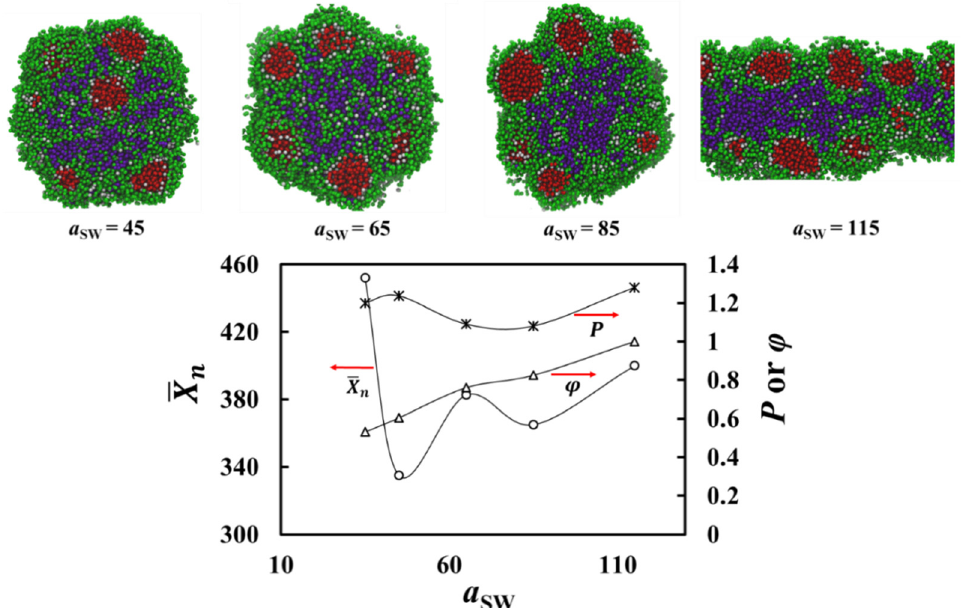
Figure 6. Aggregate snapshots and analysis of the aggregate structural changes when a SW is varied. At the top, the cross-sections of the final morphology of the system containing A 19 (4%), A 1 - b -S 6 (13%), and S 6 (3%) are presented. Solvent beads are omitted in the visualizations for clarity. The color scheme is the same as in Figure 1. At the bottom, the mean aggregation number, X n , polydispersity index (P) of solvophobic cores, and order parameter ( ϕ ) of the aggregates are shown as a function of the interaction parameter between the more solvophilic polymer and solvent a SW . Error bars are smaller than the symbol size. The scatter in the data is due to finite size effects in the simu- lations.